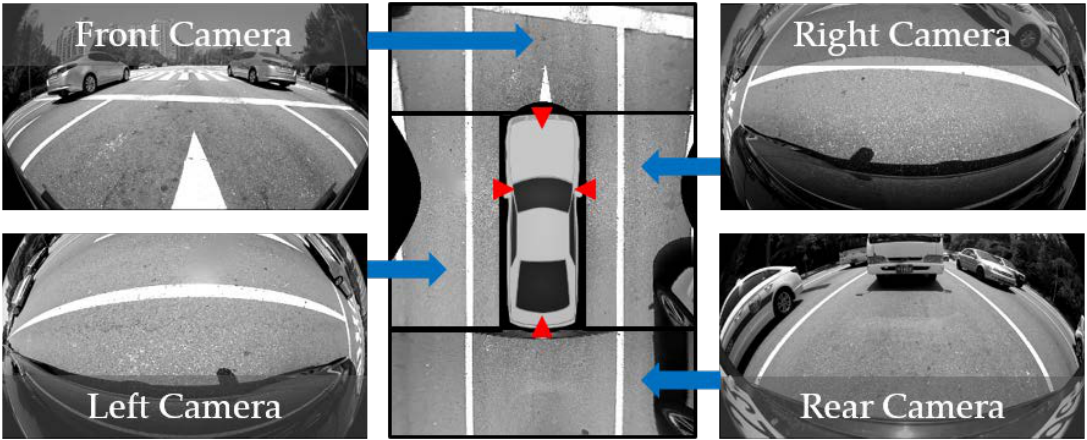
Figure 1. Camera configuration of the around view monitor (AVM) system. Red triangles indicate four cameras of the AVM system.